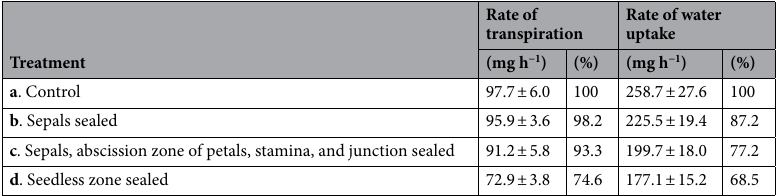
Table 2. Rates of water movement for transpiration and osmotic uptake along different pathways through the strawberry fruit surface (cv. Sonsation). Fruits were progressively sealed, starting from the proximal end. Treatment a (‘Control’): Fruit without sealing served as control. The sealing treatments were: Treatment b (‘Sepals sealed’): sepals and the peduncle surface sealed, open remained the abscission zones of petals, stamina, the junction between calyx and receptacle, and the seedless zone of the receptacle. Treatment c (‘Sepals, abscission zones, stamina, and junction sealed’): sepals, abscission zones of petals and stamina, peduncle and junction calyx-receptacle cut end all sealed. Treatment d (‘Seedless zone sealed’): seedless zone of the receptacle, sepals, abscission zone of petals and stamina, calyx-receptacle junction, peduncle removed and sealed.